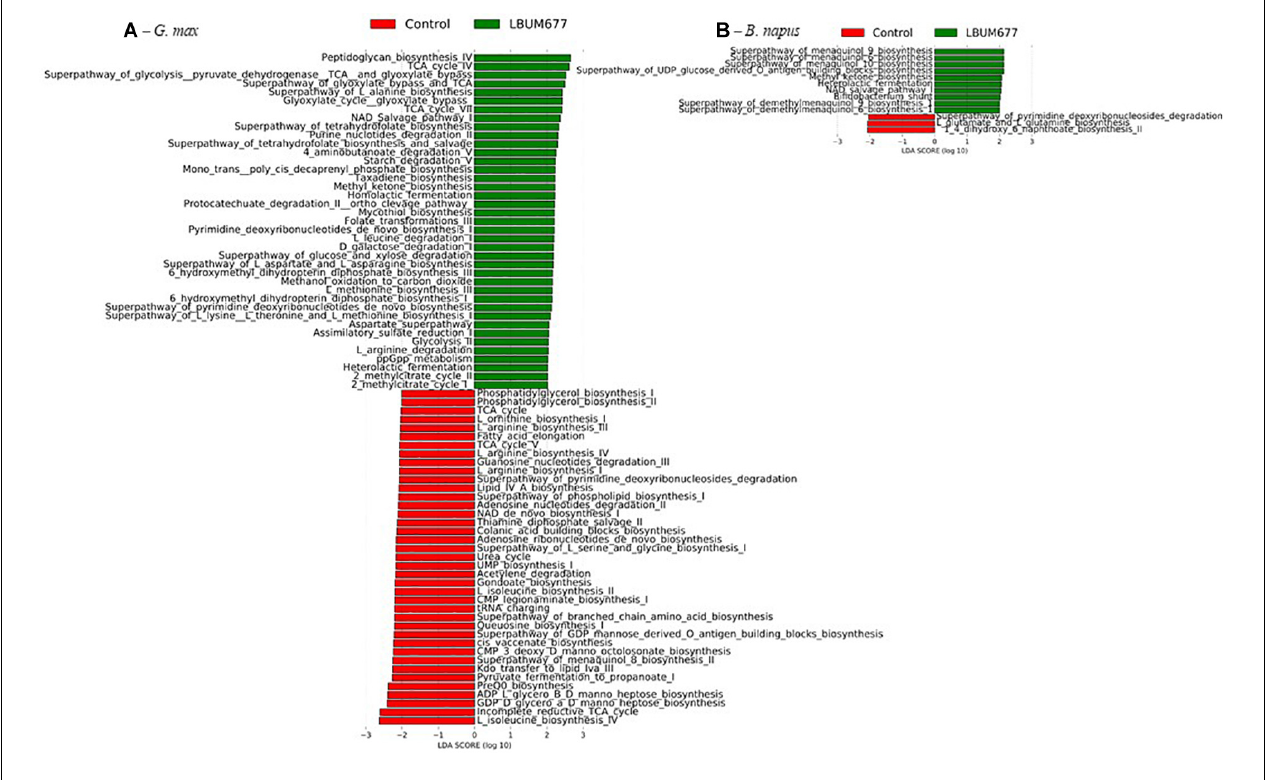
FIGURE 10 | Histogram of the LDA scores computed for differentially abundant MetaCyc pathways in control samples and in LBUM677-treated samples as determined using LEfSe. (A) G. max plants and (B) B. napus plants. Differentially abundant sequences were determined using the non-parametric factorial Kruskal-Wallis sum-rank test. A subsequent Linear Discriminant Analysis was used to estimate the effect size of each differentially abundant